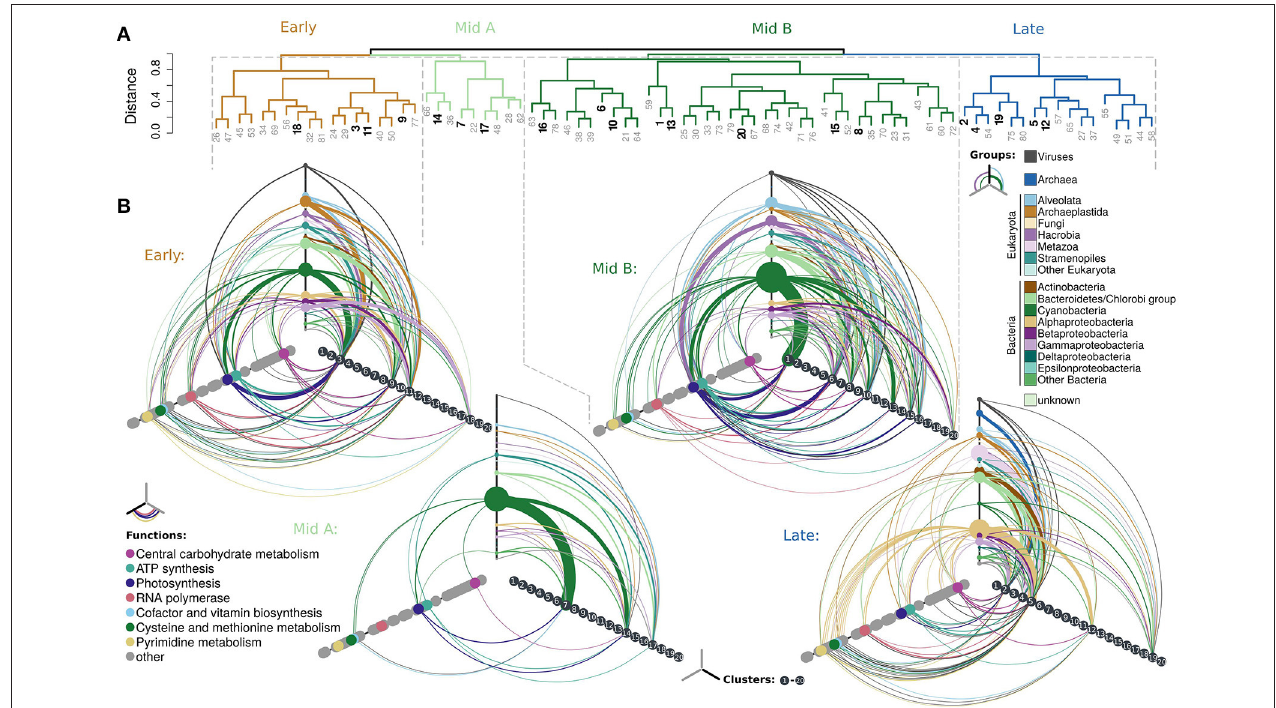
FIGURE 3 | Eigengene networks of the Askö 2012 metatranscriptomic time-series. (A) Dendrogram as shown in (B) . Hive plots illustrating relationships between taxonomic groups (top axis) and their contributions to gene expression associated with specific functions (left axis) and among the clusters 1–20 (right axis). Line widths correspond to the fraction of total gene expression that share the annotation categories defined on the Hive axes. A line going from one axis to another resembles the fraction of ORFs that have, for example, a specific functional and taxonomic annotation. Not all points on the Hive axes have connections because each cluster is only part of one of the major groups resembled by the Hives (for example, clusters 3, 9, 11, and 18 are only part of the Early Hive). Each ORF is only contained once and does not re-occur in multiple hive plots or the clusters